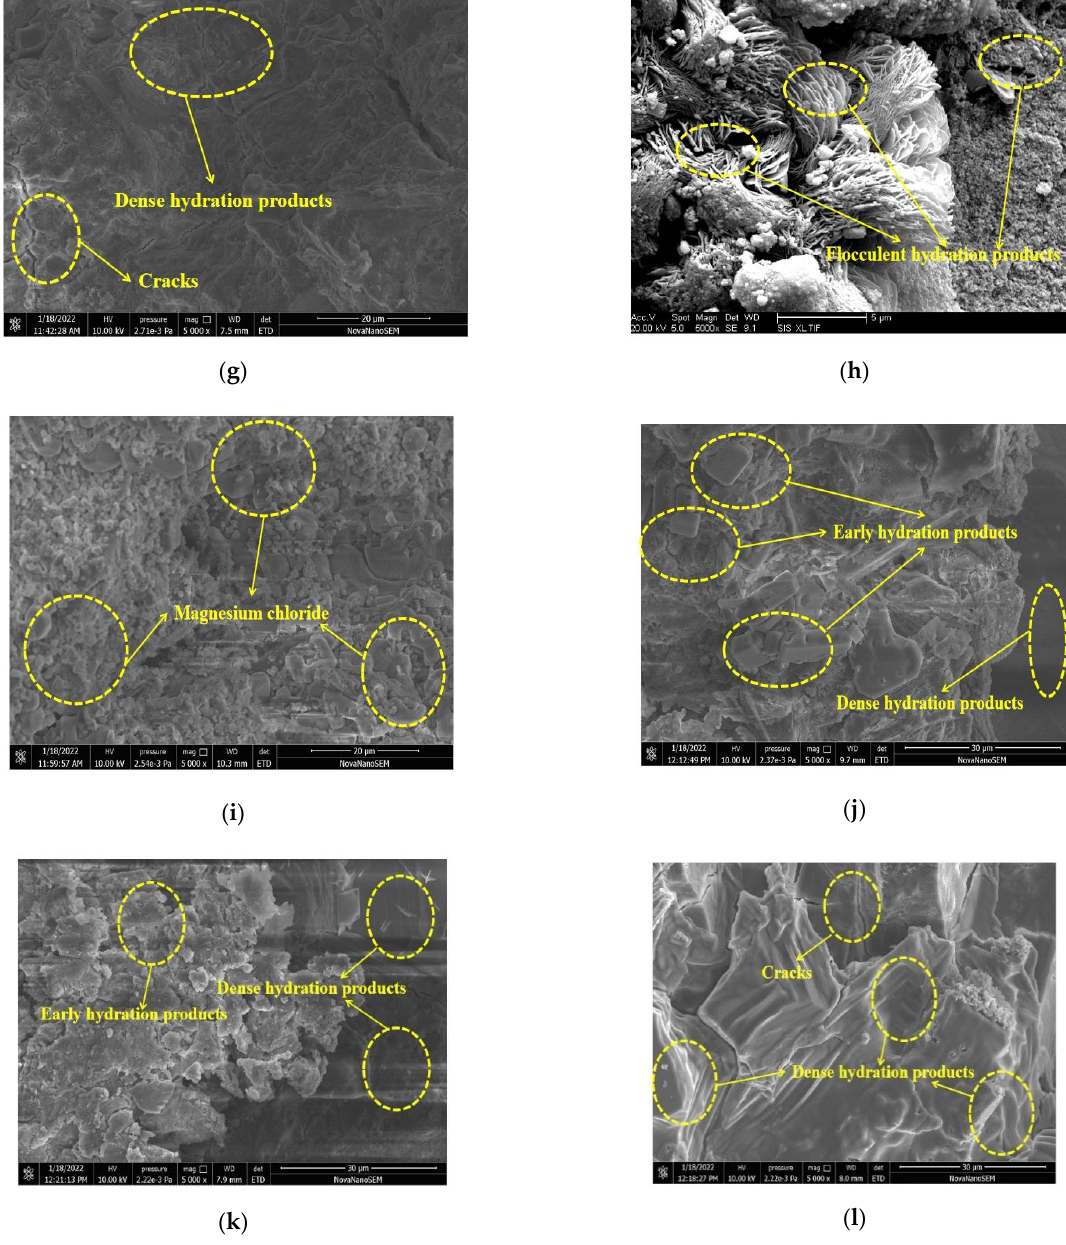
Figure 10. SEM micrographs of specimens. ( a ) Cured for 3 h-0% MgCl, ( b ) Cured for 1d-0% MgCl, ( c ) Cured for 3 d-0% MgCl, ( d ) Cured for 28 d-0% MgCl, ( e ) Cured for 3 h-2% MgCl, ( f ) Cured for 1 d-2% MgCl , ( g ) Cured for 3 d-2% MgCl, ( h ) Cured for 28 d-2% MgCl, ( i ) Cured for 3 h-4% MgCl, ( j ) Cured for 1 d-4% MgCl, ( k ) Cured for 3 d-4% MgCl, ( l ) Cured for 28 d-4% MgCl.